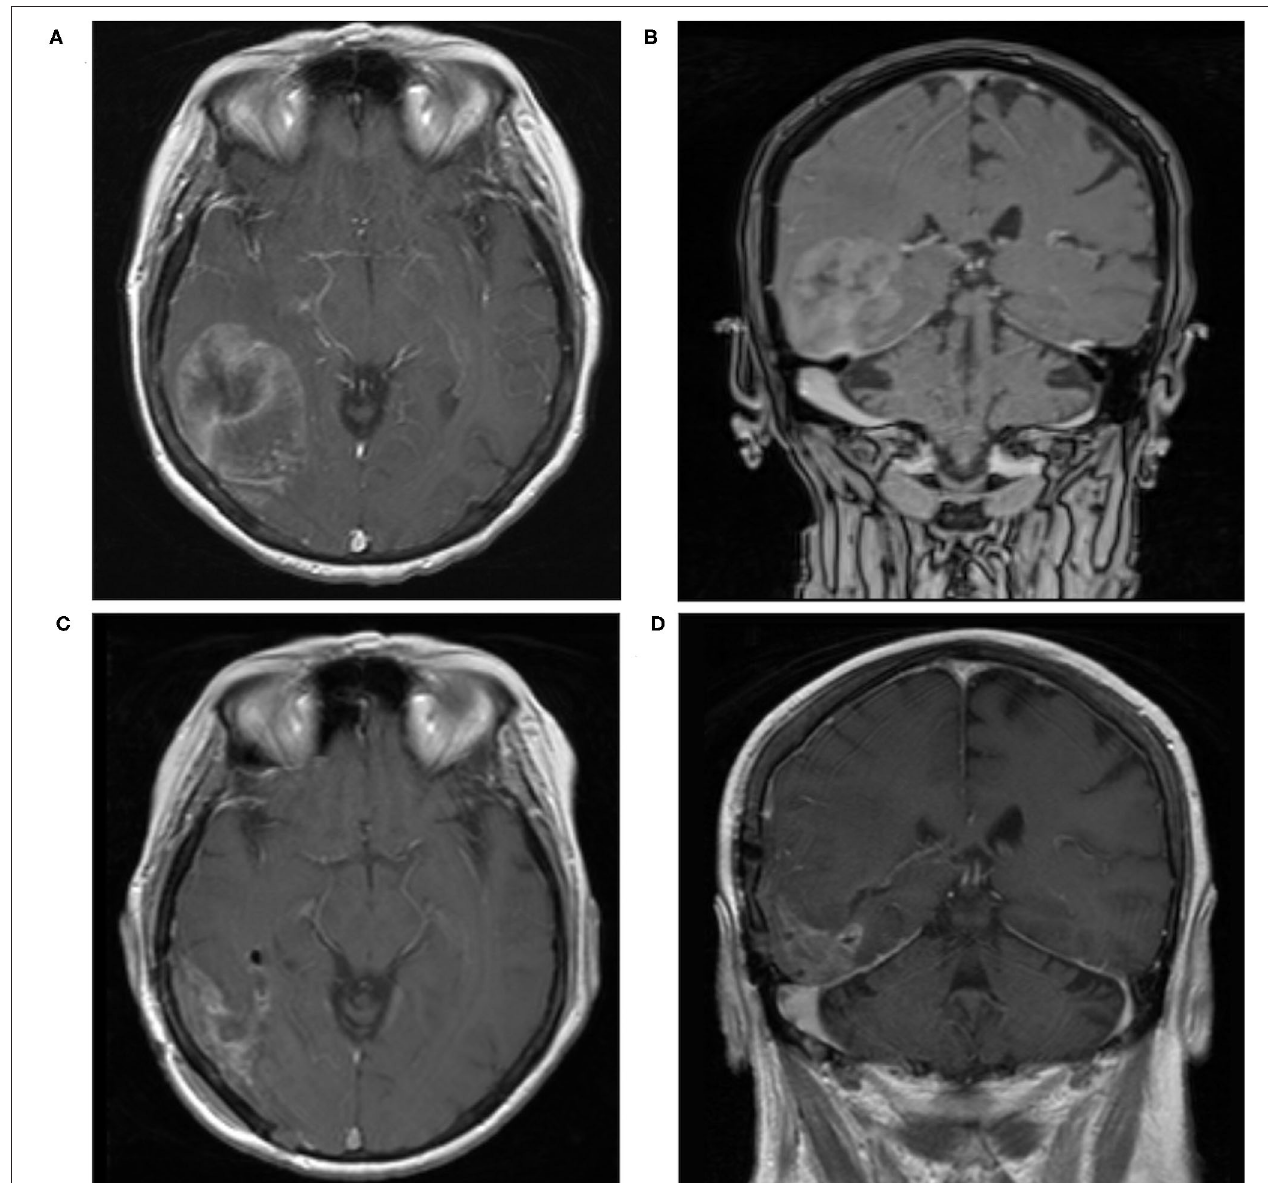
FIGURE 1 | (A,B) Initial T1-weighted MRI with contrast demonstrates a large right posterior temporal heterogeneously enhancing lesion with scattered calcifications and surrounding vasogenic edema that appeared to arise from the right tentorium. (C,D) Postoperative T1-weighted MRI with contrast demonstrates expected postoperative changes with minimal residual along the